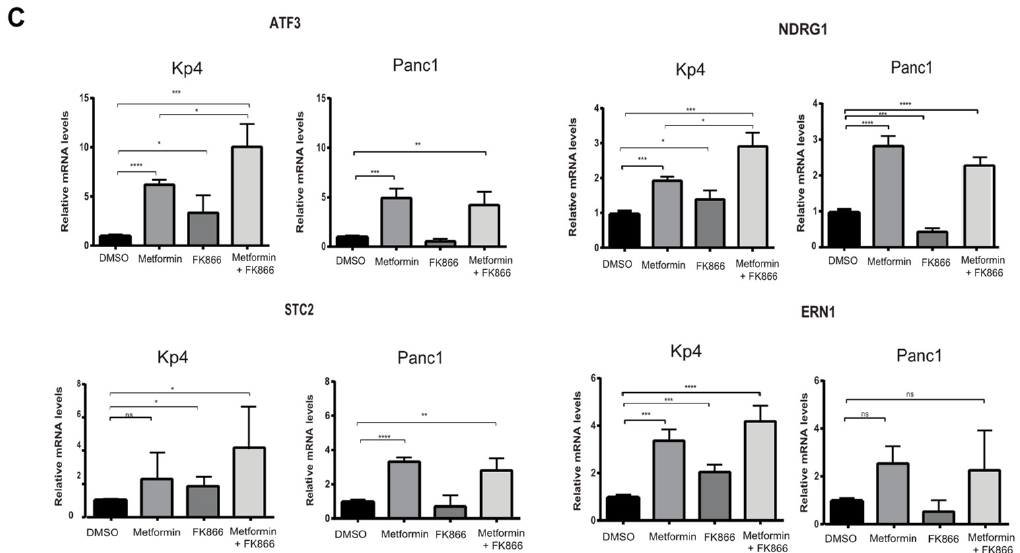
Figure 7. The combination of Met+FK activates the p53 pathway and the unfolded protein response (UPR). ( A ) p53 gene set that overlaps with gene expression changes in KP4 cells treated with met- formin and FK866 in comparison to vehicle, metformin alone, or FK866 alone. ( B ) UPR gene set that overlaps with gene expression changes in KP4 cells treated with metformin and FK866 in comparison to vehicle, metformin alone, or FK866 alone. ( C ) RT-qPCR validation of some gene expression differences found in ( A ) and ( B ). Data are normalized over TBP and HMBS and presented as means relative to control cells (vehicle condition). Values are means of triplicates ± SEM. * p -value ≤ 0.05, ** p -value ≤ 0.01, *** p -value ≤ 0.001, **** p -value ≤ 0.0001 (ANOVA), n = 3.